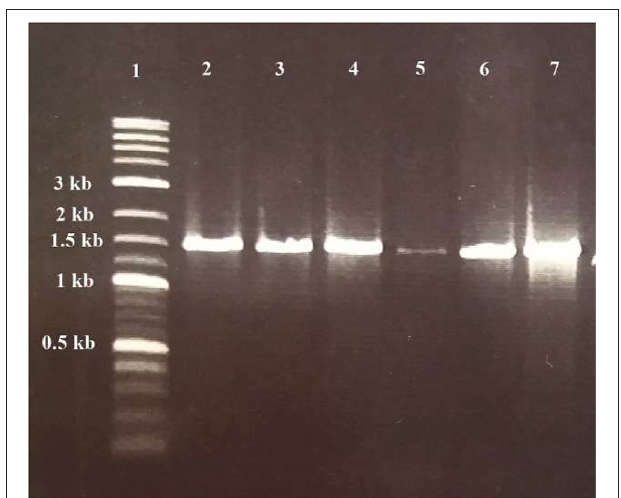
FIGURE 6 | Gel electrophoresis of PCR products for detection of Actinomycetes isolates. Lane 1: DNA ladder (Fermentas, Germany); lane 2, 3, 4, 5, 6, and 7: positive samples of Streptomyces sp. (WA-1), S. nobilis (WA-3), S. kunmingenesis (WC-3), S. mutabilis (WD-3),